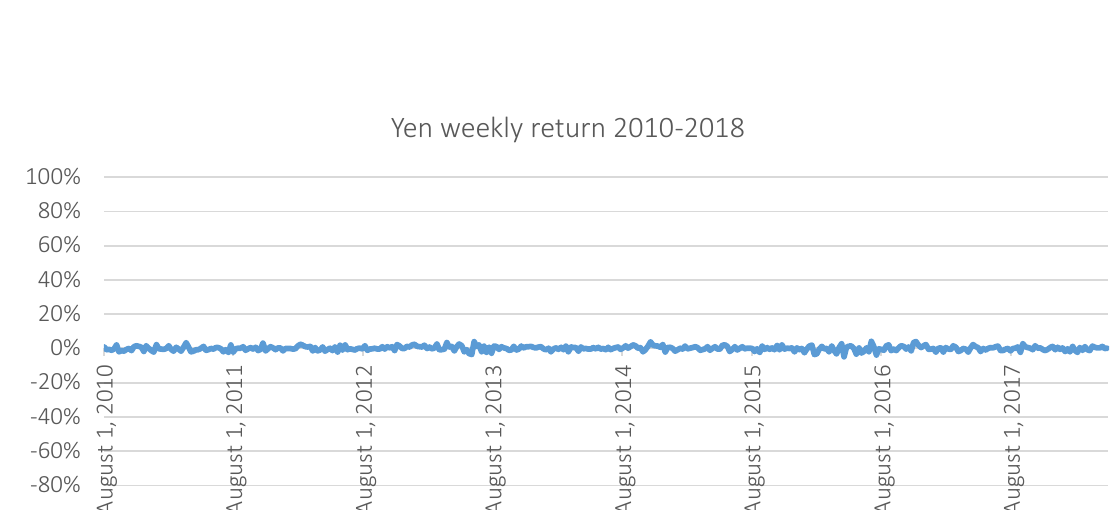
Figure 4. Returns for the Euro 2010–2018